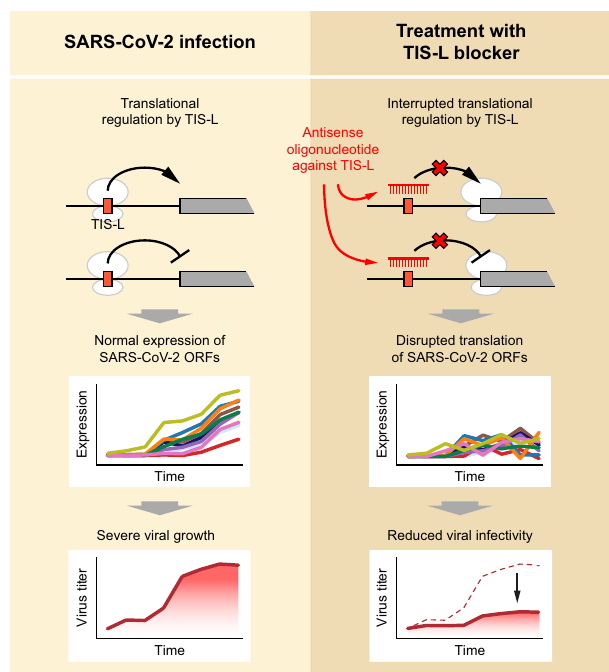
Fig. 7 A hypothetical therapeutic strategy for SARS-CoV-2 treatment by blocking TIS-L with antisense oligonucleotide (ASO). By blocking the TIS- L with ASO, the viral infectivity of SARS-CoV-2 could be reduced by the disruption of the translation of the viral